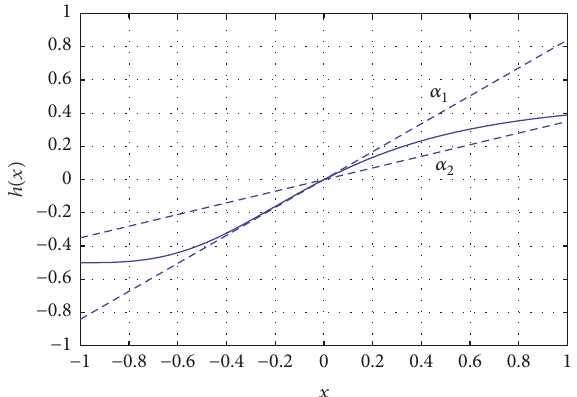
Figure 4: Hill function ℎ(𝑥) and its bounds. In this picture, the solid line is the considered Hill function and dashed lines are the corresponding bounds.